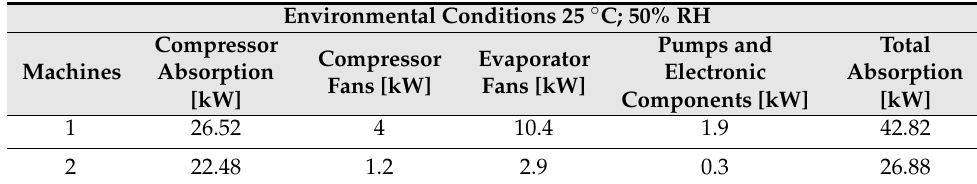
Table 6. Major items consumption.